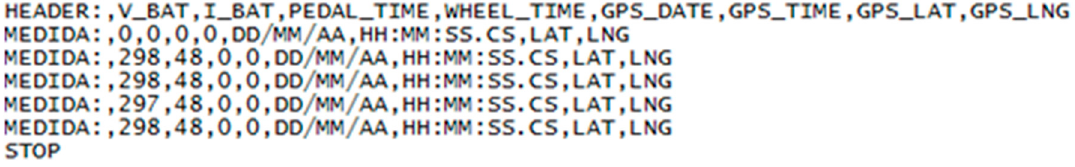
Figure 14. Sample of recorded data for 15 V and 1 A test.